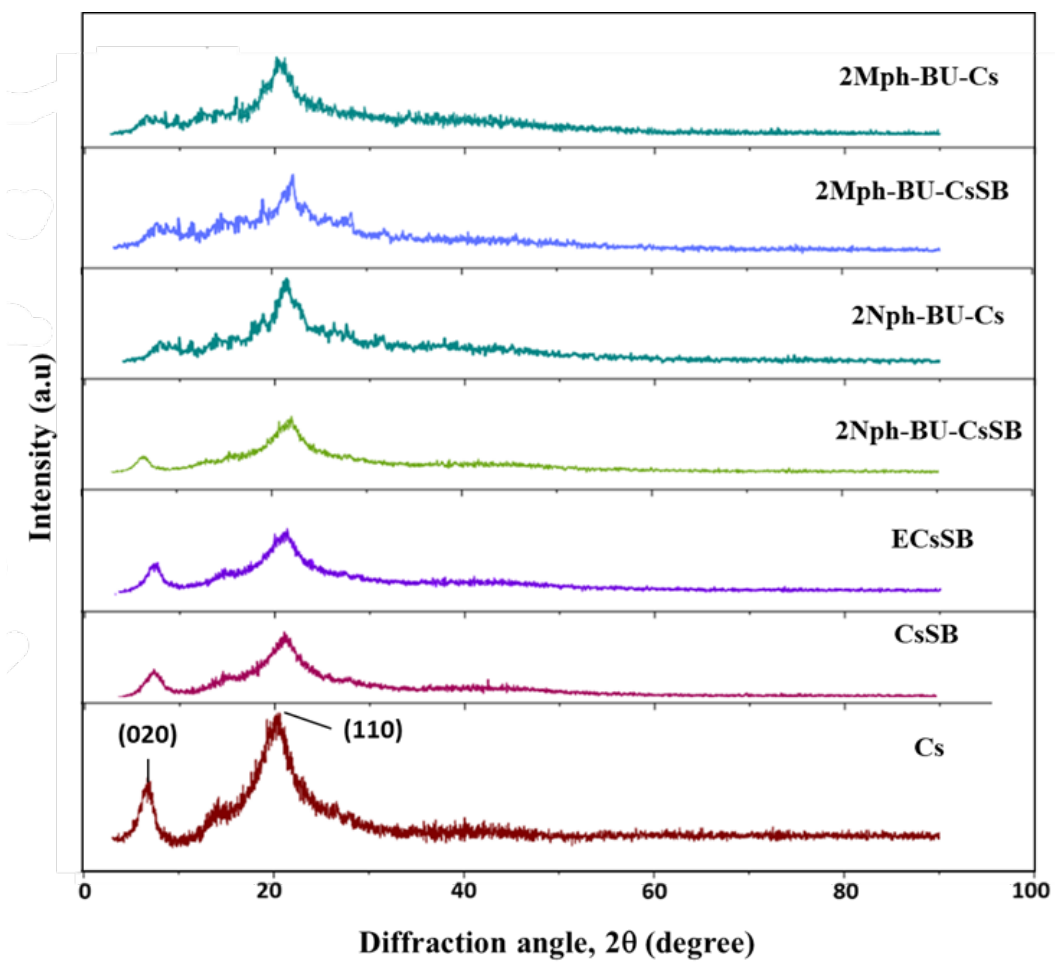
Figure 4. XRD patterns of 2Mph-BU-CsSB, 2Mph-BU-Cs, 2Nph-BU-CsSB, and 2Nph-BU-Cs hy- drogels.